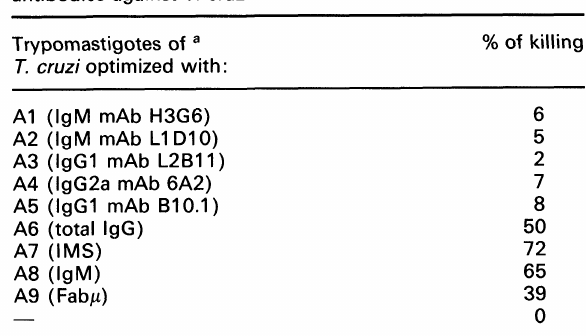
Table 1. C-dependent lysis of the trypomastigote forms of T. cruzi pre-opsonized with mouse monoclonal or polyclonal antibodies against T. cruzi Trypomastigotes of T. cruzi optimized with"